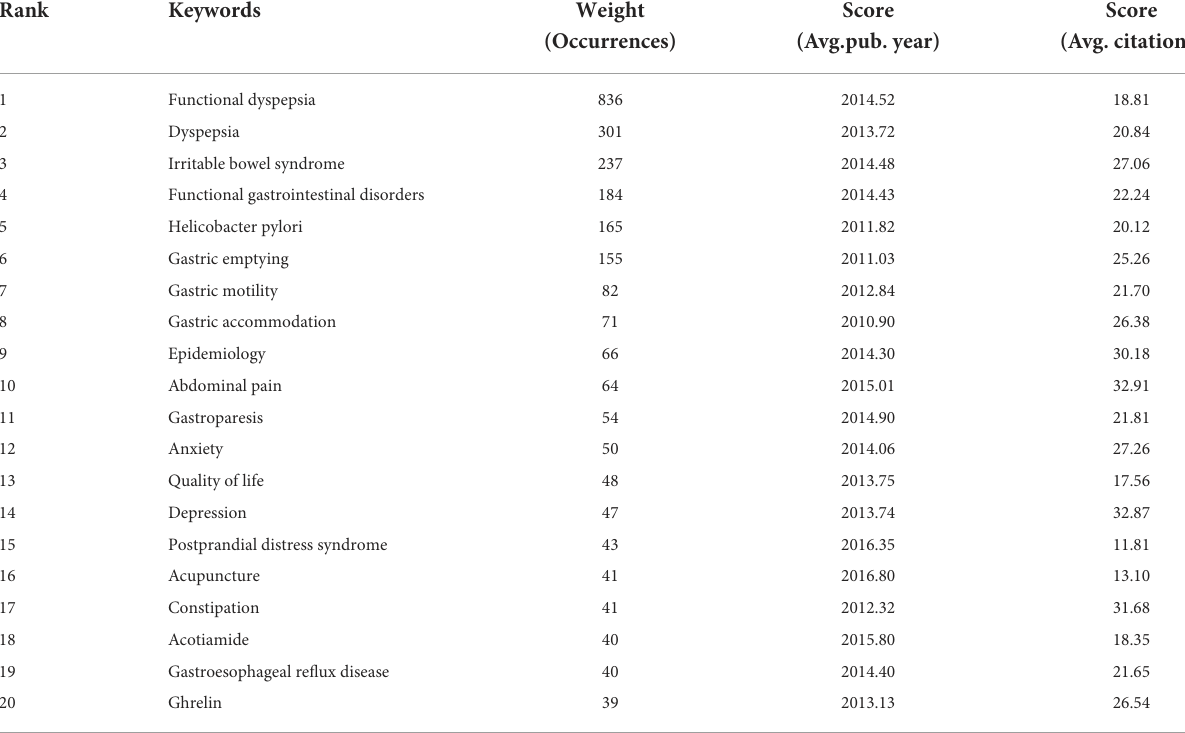
TABLE 7 Occurrence times, average publication years, and average citation times of the top 20